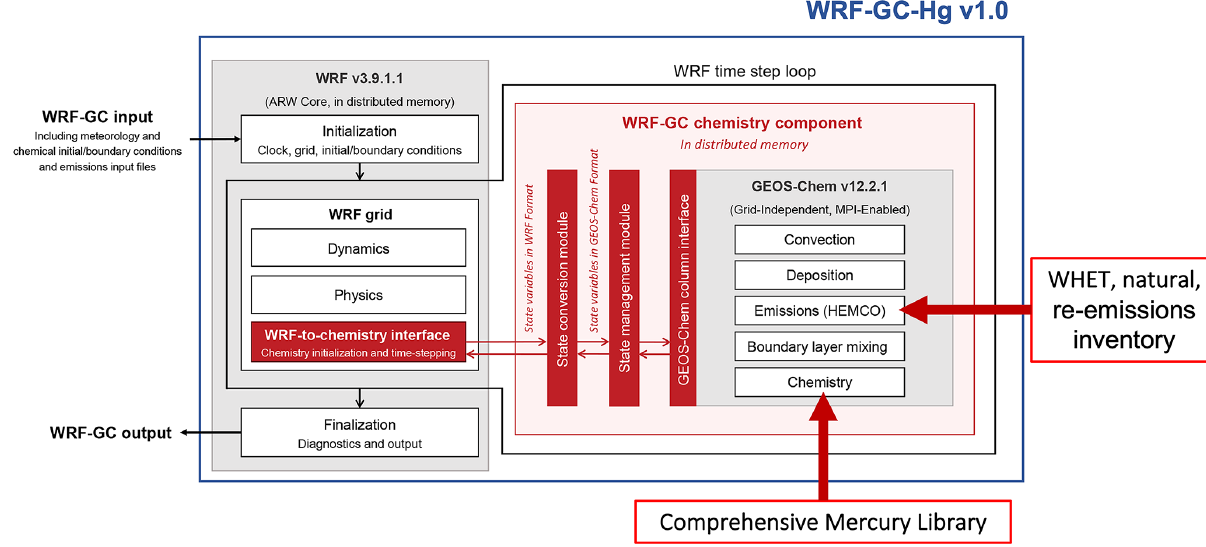
Figure 1. WRF-GC-Hg v1.0 framework based on WRF-GC v1.0 (Lin et al., 2020).